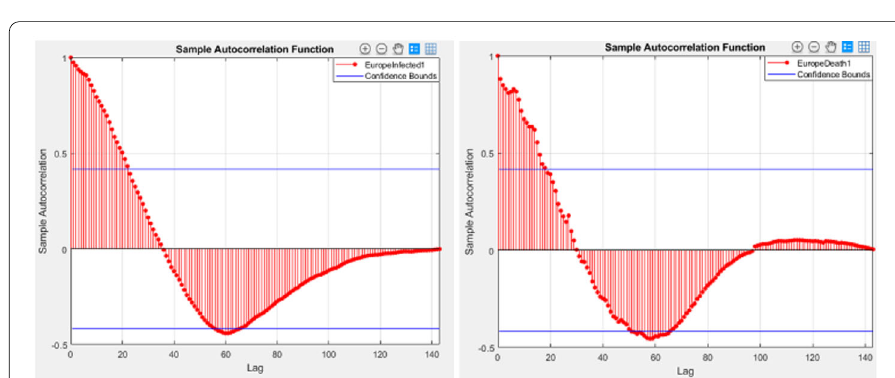
Figure 2 Autocorrelation function for the infected and deaths in